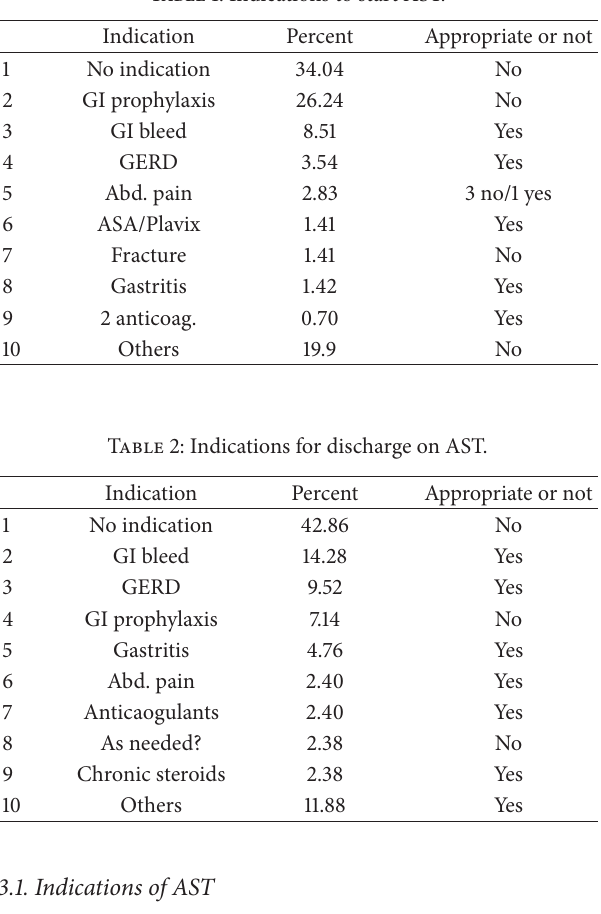
Table 1: Indications to start AST.